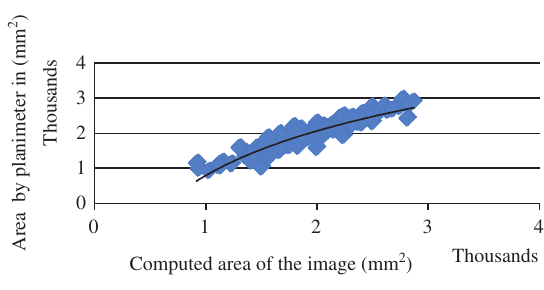
Figure 8: Curve of Best